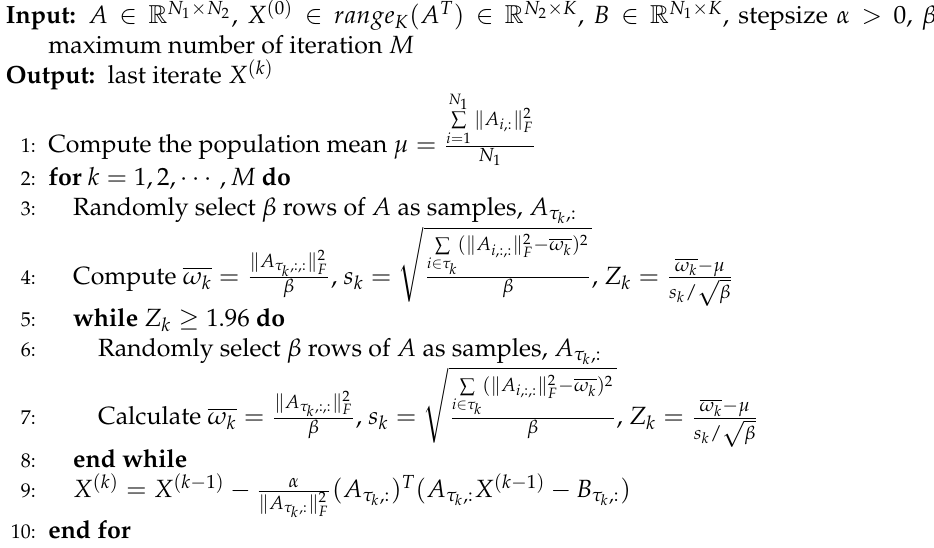
Algorithm 6 Matrix randomized average Kaczmarz algorithm with random sam- pling